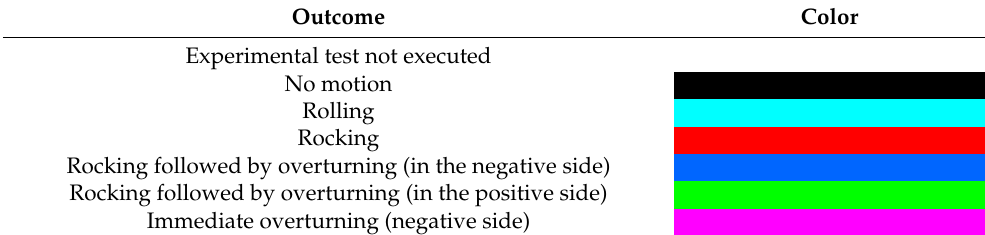
Table 12. Color legend of the stability spectra in Figure